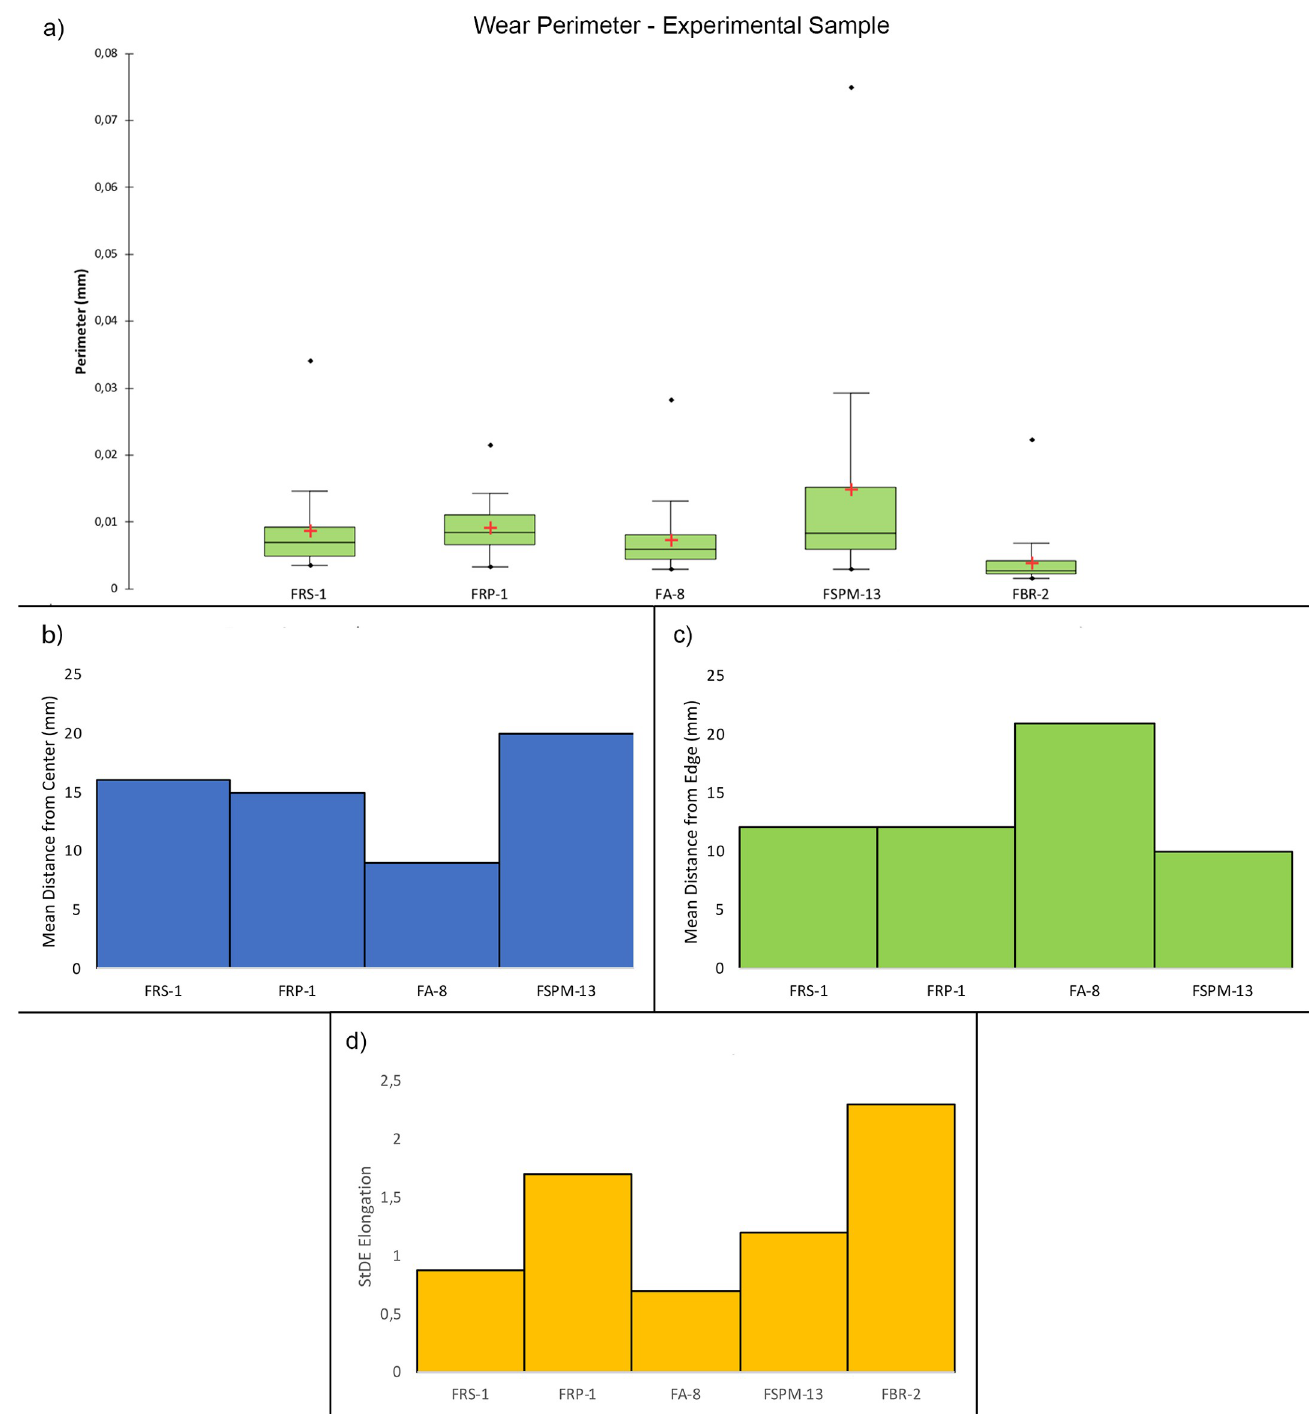
Fig 18. Perimeter of the wear. (a) Dimensions of the wear identified over the utilized areas of the experimental replicas; (b) mean distance of the identified wear from the object centre; (c) mean distance of the identified wear from the object edge; (d) dispersion of the identified wear over the tool surface defined by the elongation of the standard deviational